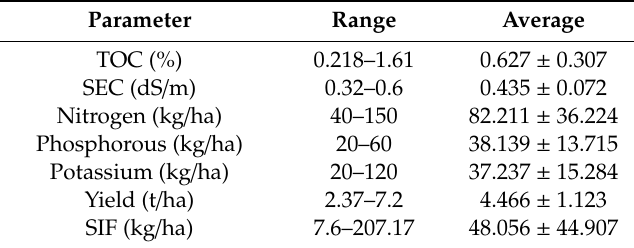
Table 1. Range, average, and standard deviation of the parameters used for developing the artificial neural network (ANN) for modelling methane (CH 4 )